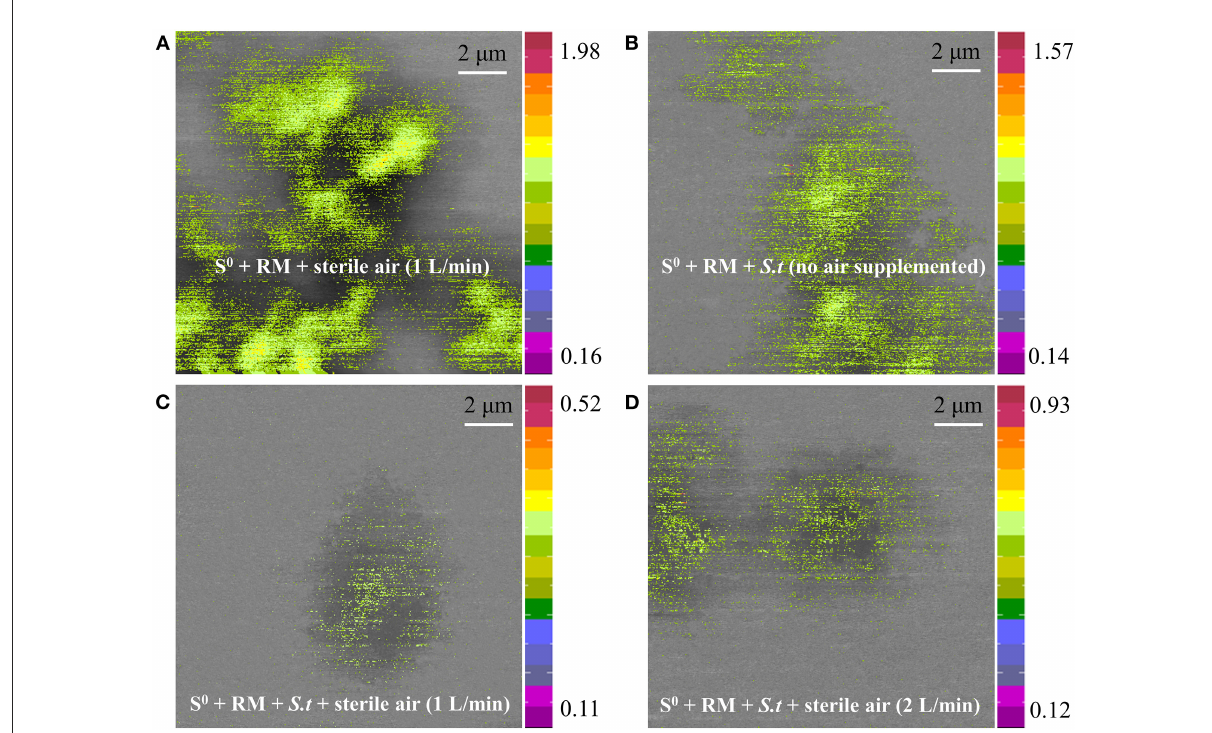
FIGURE10 Sodium distribution on the surface of solid residues after RM bioleaching, analyzed by STXM. Leaching was conducted for 27 days in a 5-L STR with the S 0 /RM mass ratio of 2:1. Residues from the following assays were analyzed: (A) S 0 + RM + 1L air/min; (B) S 0 + RM + Sb. thermosulfidooxidans ( S.t ) + 0L air/min; (C) S 0 + RM + S.t + 1L air/min; (D) S 0 + RM + S.t + 2L air/min. The numbers next to the color bars indicate the maximal and minimal contents of Na in each mapping (unit: 1 × 10 − 5 g/cm 2 ).